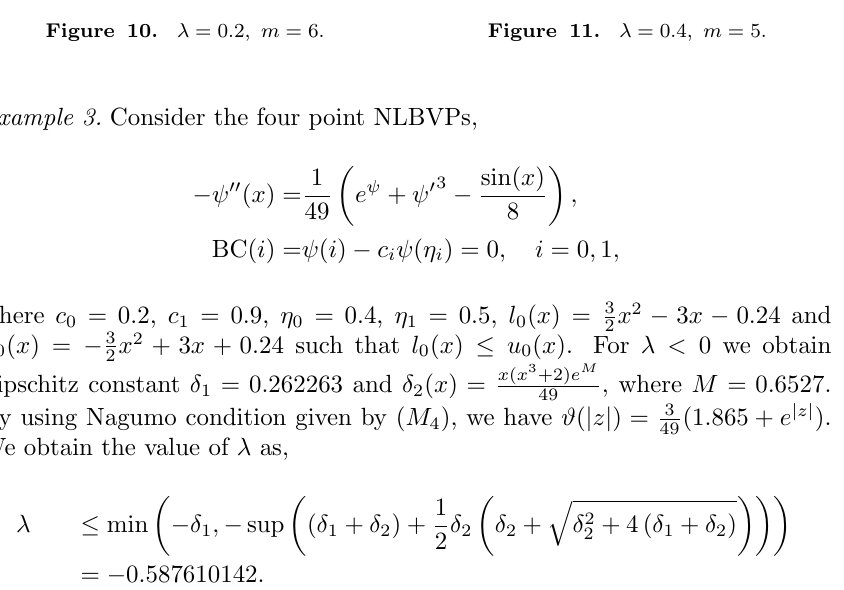
Figure 10. λ = 0 . 2 , m = 6 . Figure 11. λ = 0 . 4 , m = 5